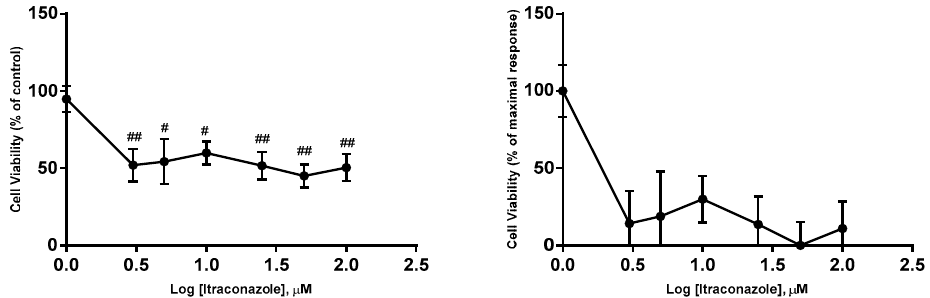
Figure 5. Concentration-effect curves obtained for itraconazole. The drug was added in fresh medium, in sextaplicates. Results are presented as mean ± SEM of five independent experiments. The left curve represents the viability of cells (% of control), whereas the right curve represents a normalization between 0 and 1 (0% and 100%), where 100% was defined as the concentration of the drug that less affected the cell viability, and all other data points were normalized to this value, being 0% defined as the concentration that affected the cell viability more. ## p < 0.01 and # p < 0.05 vs.